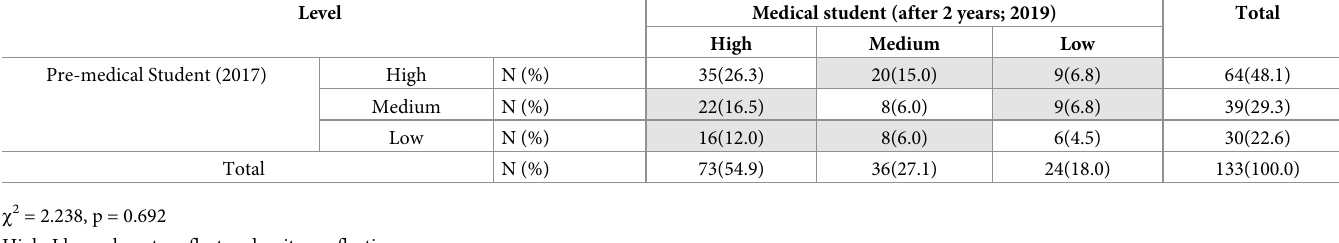
Table 2. Changes in the understanding of self-reflection methods.